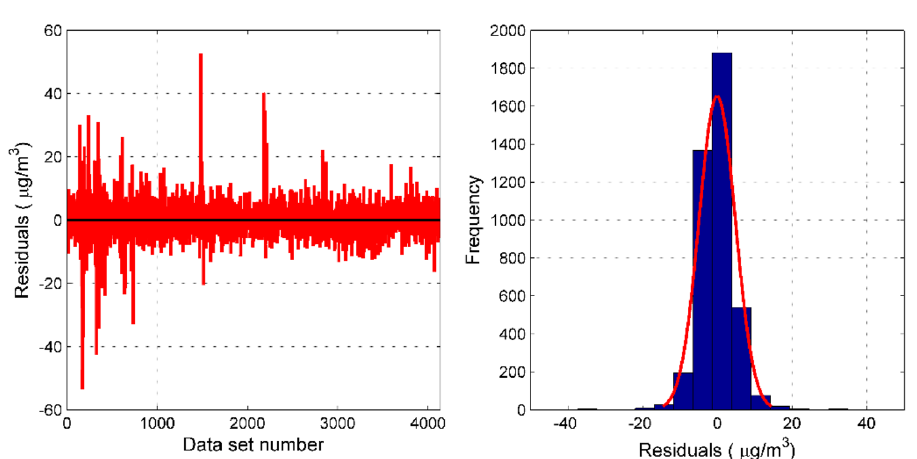
Figure 8. Residual test of PM 2.5 ’s PCA–RVM–NAR model. The residual plot of the PCA–RVM–NAR model is seen on the left. The histogram of the residuals is seen on the